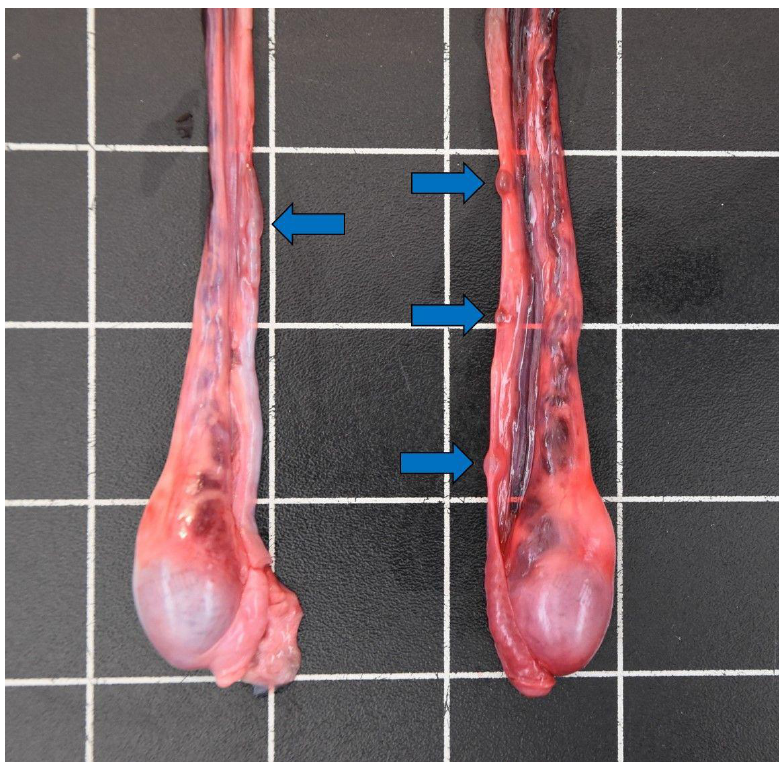
Figure 8. Cysts on the vas deferens (blue arrows) of a male otter (5.5–7.5 years) from Schleswig- Holstein.